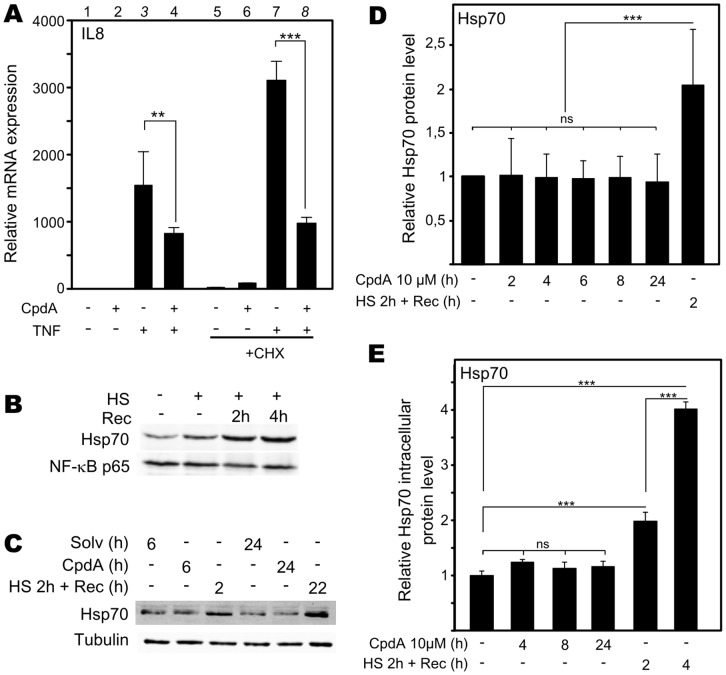
Hsp70 production is not necessary for CpdA’s anti-inflammatory action mechanism.(A) A549 cells, starved for 48h, were left untreated or were pretreated for 30′ with cycloheximide (CHX)(20µg/ml), after which solvent (Solv) or CpdA (10µM) was added for 1.5h. Subsequently, cells were incubated with TNF(2000IU/ml) for 5h. Isolated total mRNA was subjected to RT-qPCR detecting IL8, normalized to GAPDH levels. Solv was set as 1 and other conditions were recalculated accordingly. Statistical analysis (ANOVA with Tukey’s multiple comparison post test) was performed for selected pair wise comparisons (**p<0.001; **p<0.001). This figure is representative for 2 independent experiments. (B) A549 cells were heat-shocked (HS) at 43°C for 2h either or not followed by recovery time (Rec) at 37°C. (C) A549 cells were treated with Solv or CpdA (10µM) for 6h or 24h or heat-shocked at 43°C for 2h, after which cells were left to recover at 37°C for 2h (HS+Rec). (B)(C) Total cell protein extracts were subjected to Western blot analysis detecting Hsp70, with NF-κB p65 or tubulin as loading controls. These images are representative for at least 3 independent experiments. (D) shows the averaged band densitometric analysis (ImageJ) of 8 independent Hsp70 Western blot analyses. Specific Hsp70 signal was corrected for sample loading. Solv was set as 1 to allow ratio comparisons. Statistical analysis (ANOVA with Tukey’s multiple comparison post test) was performed for selected pair wise comparisons (ns not significant; ***p<0.001). (E) A549 cells were treated with solvent or CpdA (10µM) for 4h,8h or 24h or heat-shocked at 43°C for 2h, after which cells were left to recover at 37°C for 2h or 4h(HS+Rec). Total cell protein lysates were analyzed via Hsp70 ELISA. Statistical analysis (ANOVA with Tukey’s multiple comparison post test) was performed for selected pair-wise comparisons (ns not significant; ***p<0.001). This figure represents averaged data of 4 independent experiments.